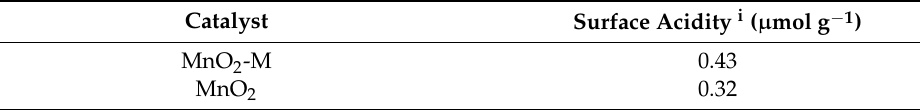
Table 4. Quantitative analysis of NH 3 -TPD over the catalysts.